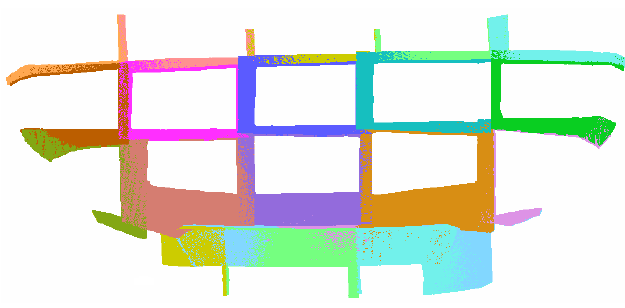
Figure 9. Overlapping areas between all the aligned point clouds.